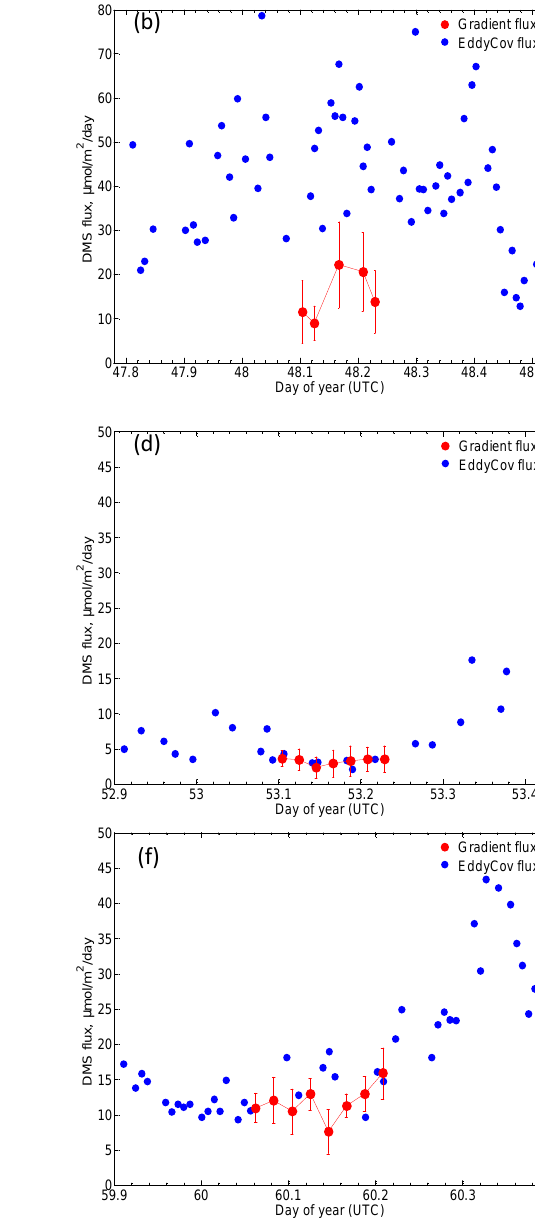
timates of K over 30 min intervals. Figure 7a shows a plot of K derived by both methods where coincident data were available, against wind speed adjusted to neutral stability, to- gether with the COAREG3.1 parameterization. The GF K values are generally lower than the EC K values, consistent with a similar bias in the flux comparison (Fig. 6), but show ever, there is a clear anomaly with the COAREG curve